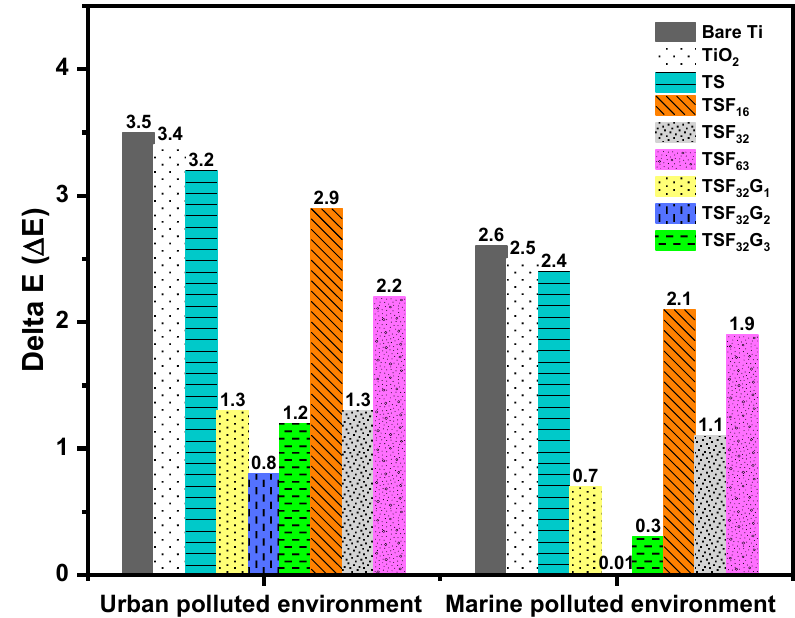
Figure 14. The color difference due to the simulated soiling test for the bare and coated titanium specimens with the mimic urban and marine soils.